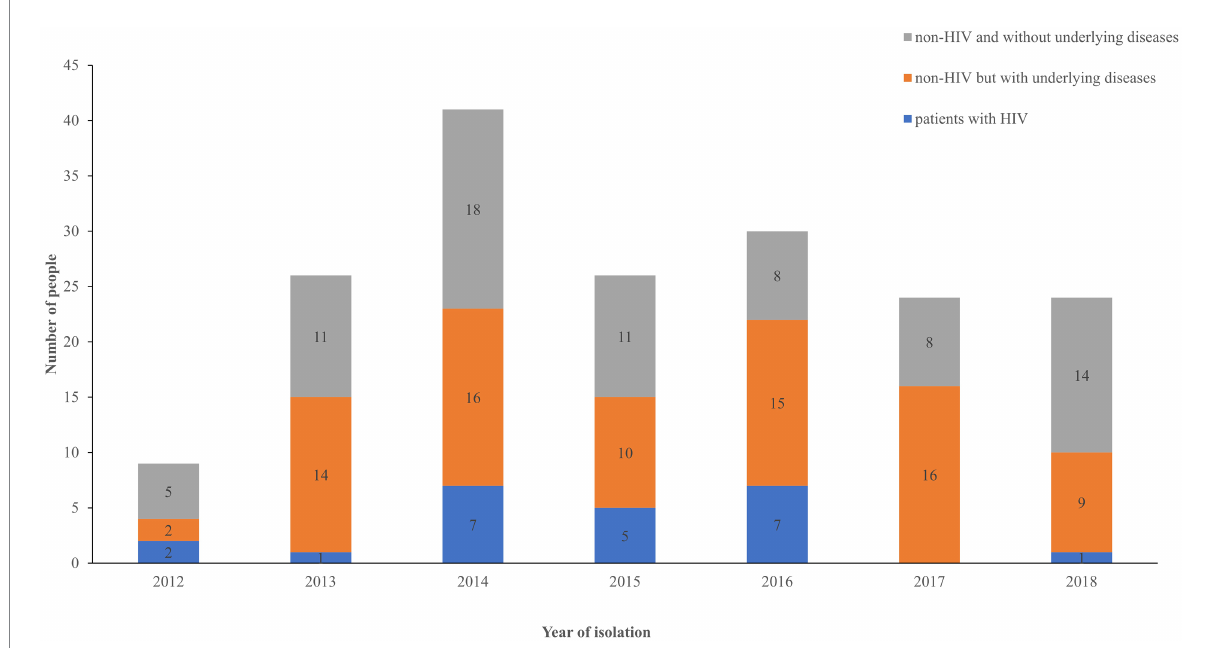
FIGURE 1 Distribution of patients among the three groups over time. Blue, HIV group; orange, non-HIV group with underlying diseases; gray, non-HIV group without underlying